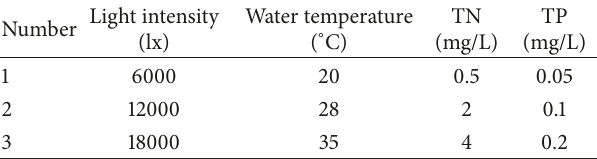
Table 1: Factor level table for orthogonal experiment.